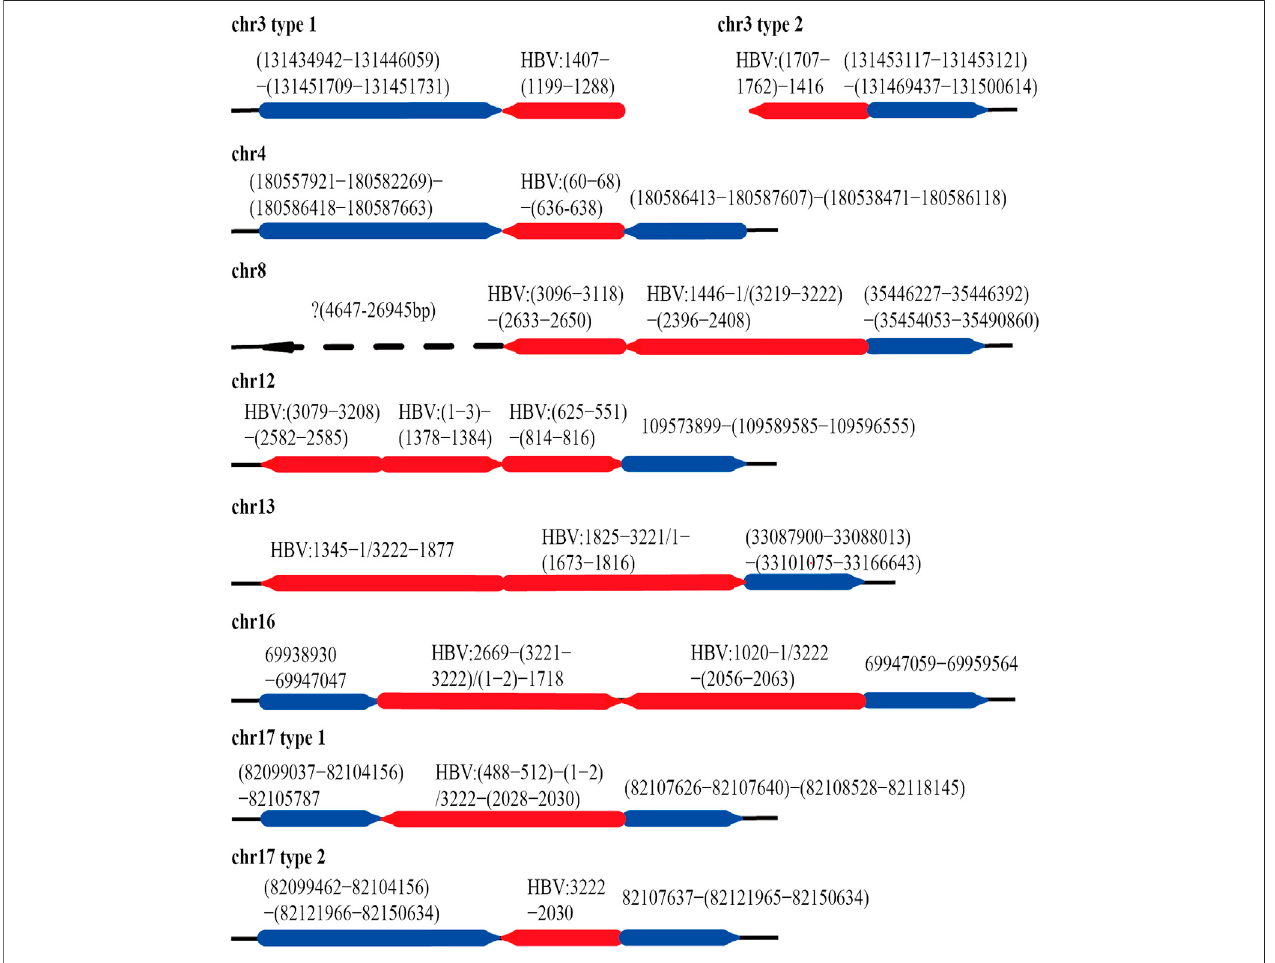
FIGURE 3 | HBV integration pattern plots of PLC/PRF/5 cell line. The red line represents the HBV genome, the blue line represents the human genome, the direction of the arrow represents the direction of the sequence, and the dashed line represents the sequence not mapping to the human reference genome.